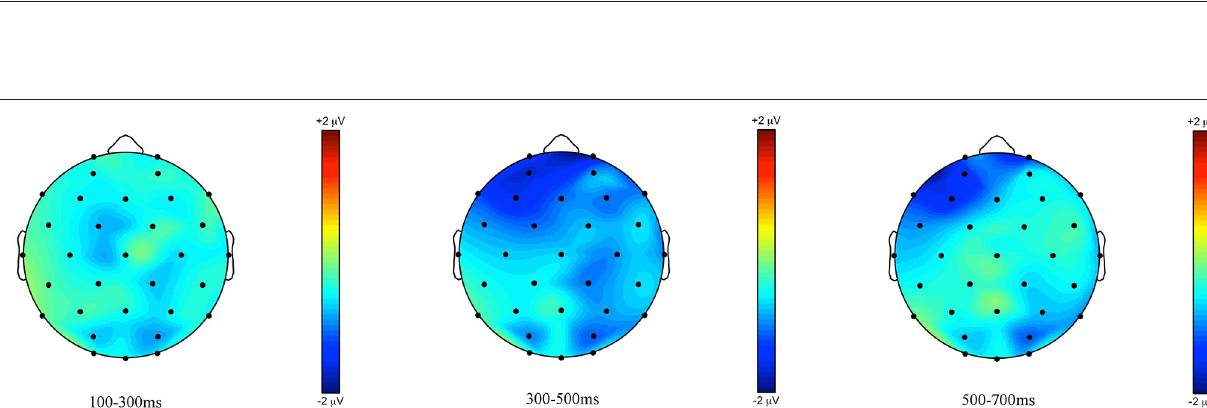
Frontiers in Psychology |